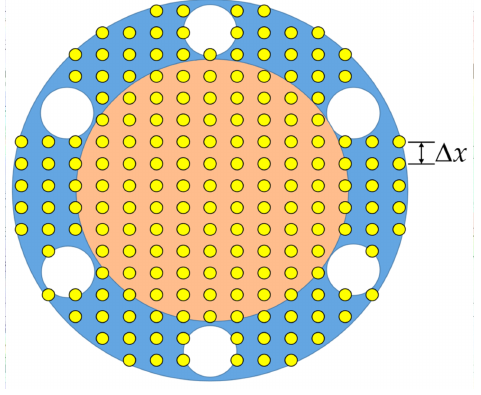
Figure 4. Illustration of PD discretization for one ply (blue colour represents the fixed boundary region and orange colour represents the inner part).